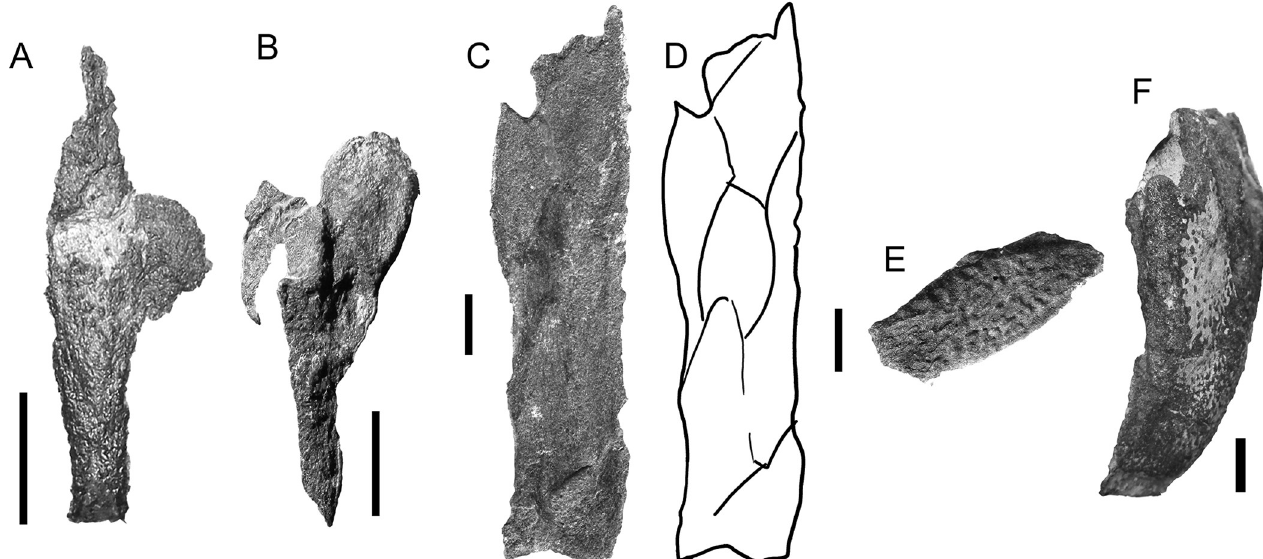
Fig 10. Bothriolepis dairbhrensis sp. nov. Elements of the distal segment of the pectoral fin elements. A. Central dorsal plate 3, NMING:F35226. B. Central ventral plate 3, NMING:F35227. C-D. Incomplete distal segment of the pectoral fin, NMING:F35228 (D, interpretation drawing). E. Mesial marginal plate 3, NHMP 59689. F. Terminal element of distal segment of pectoral fin (TCD 19618 FB1013). Scale bars 10 mm.